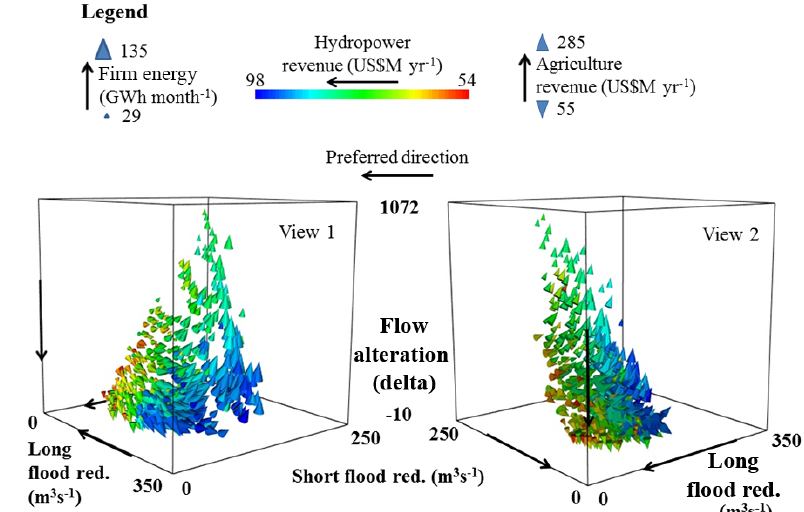
Figure 7. The same trade-off surface as Fig. 5 but with different extents of irrigation scheme implementation. Maximum agricultural revenue more than doubles but maximum flow alteration increases by 5.5 times. Increased agricultural revenue correlates with greater disturbance of the natural water environment. A 3-D animation of this plot is available in online supplementary material.